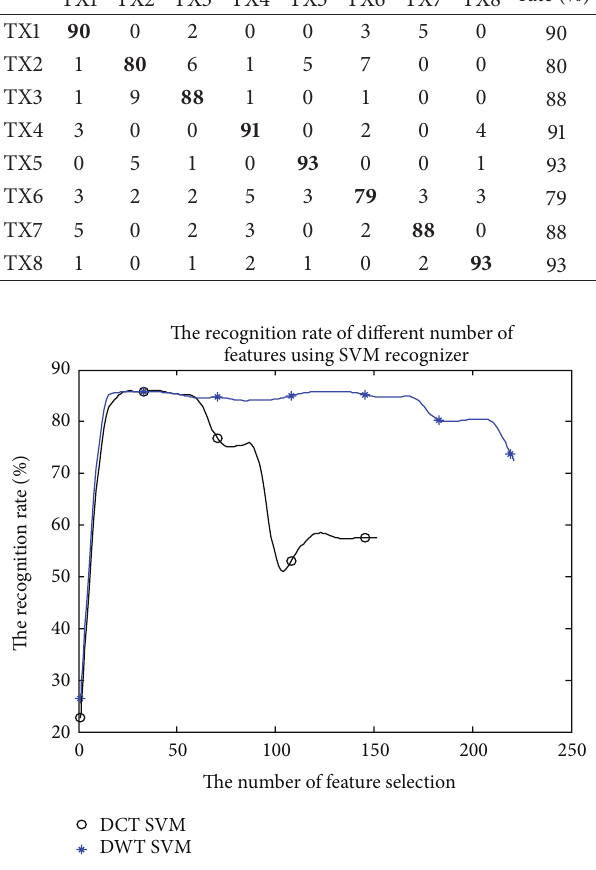
Figure 9: The comparison of the recognition results based on different sparse